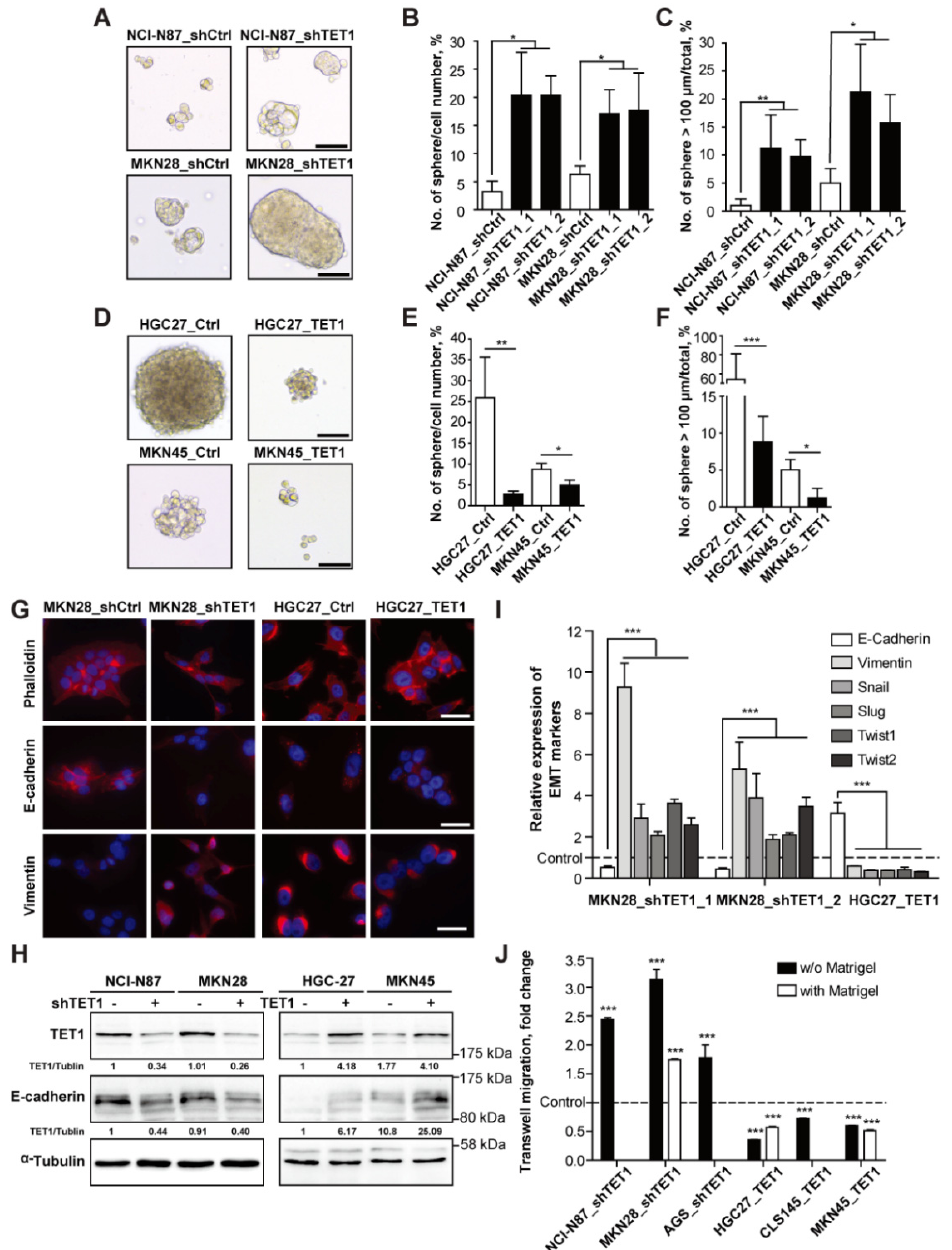
Figure 3. TET1 inhibits self-renewal of cancer stem cells and epithelial-mesenchymal transition. ( A ) Representative pictures of spheres generated by stable NCI-N87 and MKN28 cell lines. Scale bars represent 100 µ m. ( B ) Number of spheres generated per 100 cells seeded as in ( A ). ( C ) Percentage of spheres with diameter >100 µ m as in ( A ). ( D ) Representative pictures of spheres generated by stable HGC27 and MKN45 cell lines. Scale bars represent 100 µ m. ( E ) Numbers of spheres generated per 100 cells seeded as in ( D ). ( F ) Percentage of spheres with diameter >100 µ m as in ( D ). ( G ) Immunofluorescent staining of β -actin (by phalloidin), E-cadherin, and vimentin in MKN28 and HGC27 stable cell lines. Scale bars represent 100 µ m. ( H ) Immunoblot analysis showing TET1 and E-cadherin expression in stable gastric cancer cell lines. α -Tubulin was used as loading control. ( I ) qRT-PCR analysis of the EMT-related transcripts in stable cell lines transduced with shTET1 or TET1. Respective control cells were used as control. ( J ) Quantification of transwell migration assays with or without Matrigel coating of indicated stable cell lines compared to respective control cells. Error bars indicate mean ± SD. ***, p < 0.001. **, p < 0.01. *, p <